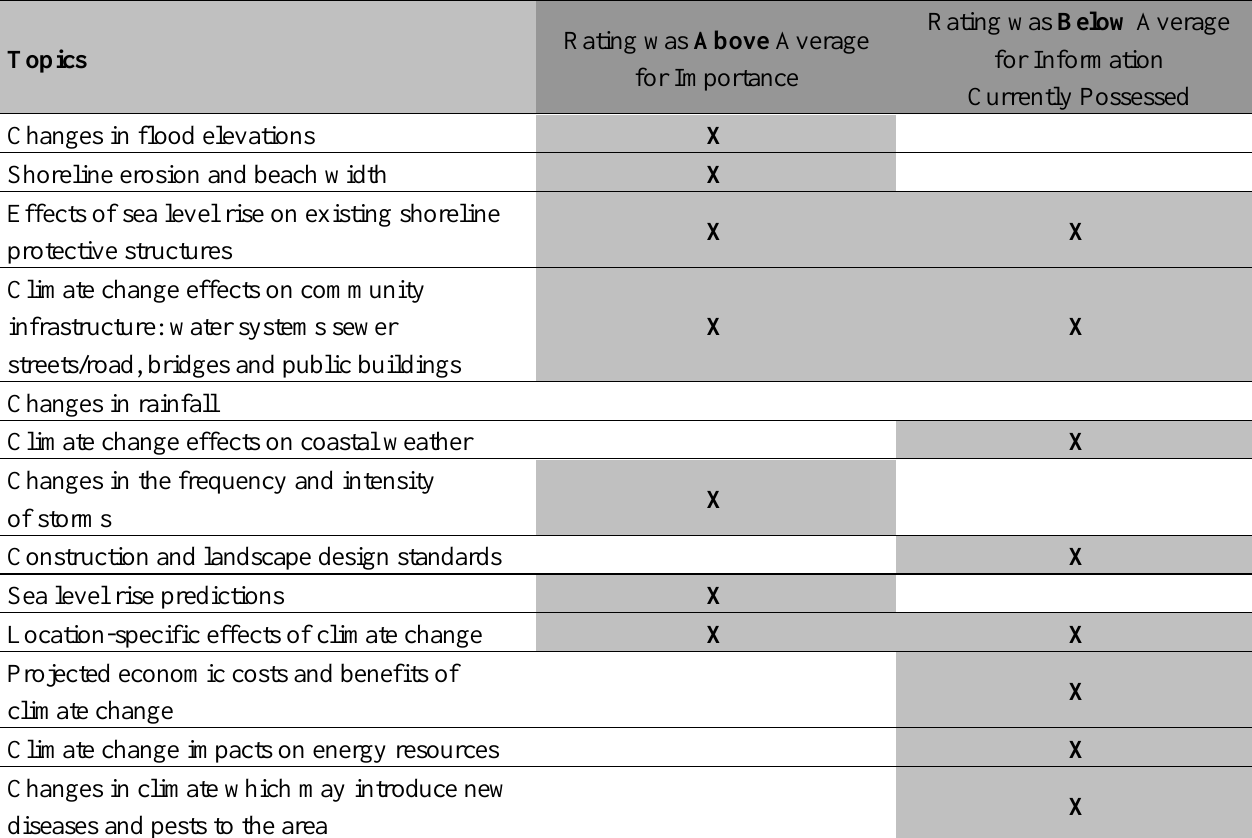
Table 3. Survey topics where the weighted responses were above the mean for “importance” and below the mean for “information currently